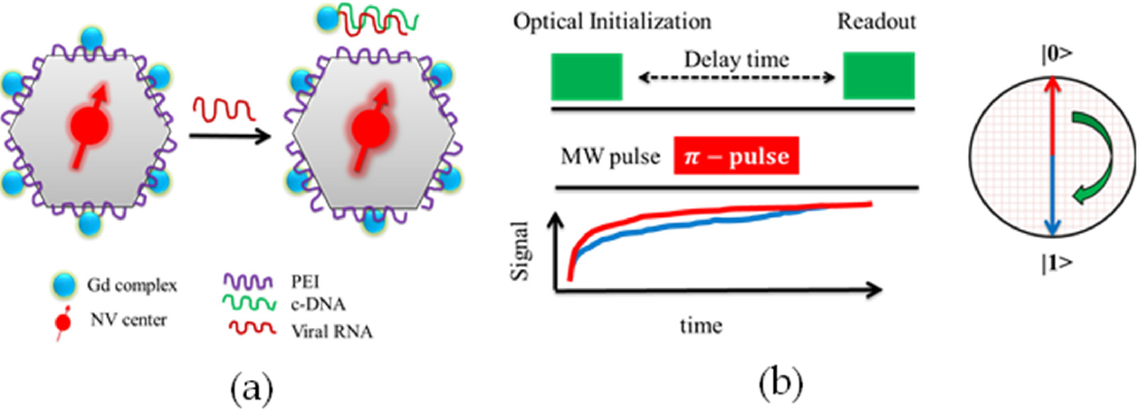
Figure 5. Schematic of SARS-CoV-2 detection using FND [75]. ( a ) Surface-modified FNDs which are coated with PEI are subject to binding with c-DNA-Gd 3+ complexes. When these modified FNDs are exposed to virus RNA, the c-DNA-Gd 3+ molecules covalently bond with the virus RNA and detach from the surface of the FND, resulting in a lower magnetic noise sensed by the NV center. The change in magnetic noise sensed by NV center can be observed in terms of NV luminescence emission. ( b ) The sequence of optical metrology using FNDs for T 1 relaxometry.